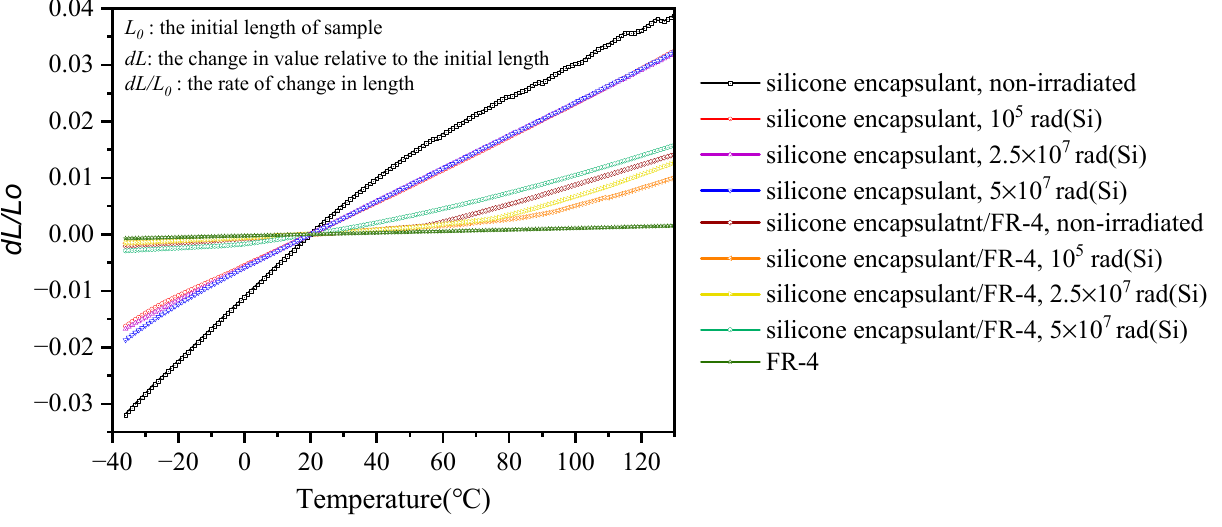
Figure 11. The thermal expansion deformation of silicone encapsulant and silicone encapsulant/FR-4.